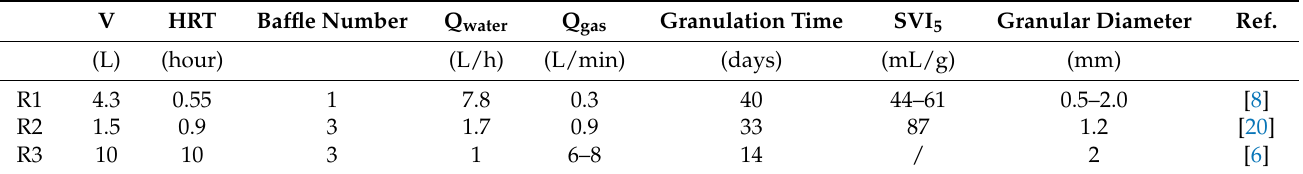
Table 1. Comparison of operational parameters and granulating efficiency in three